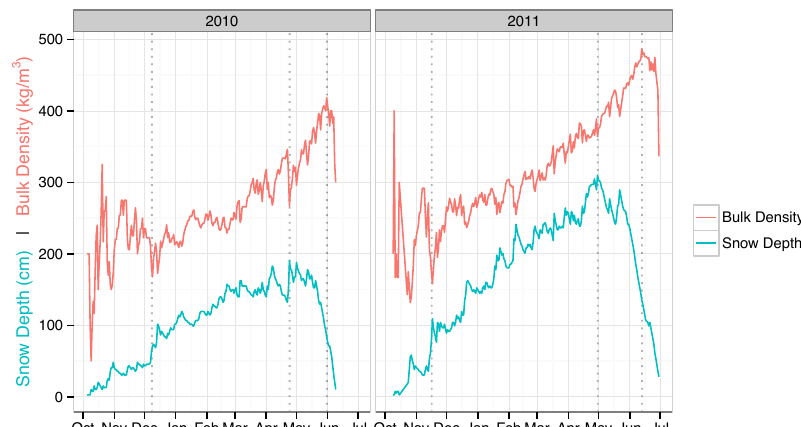
Fig. A1. Data from the Lake Irene SNOTEL site in northern Colorado. Both water years are separated into 4 phases by vertical dashed lines: early accumulation, main accumulation, main ablation, and late